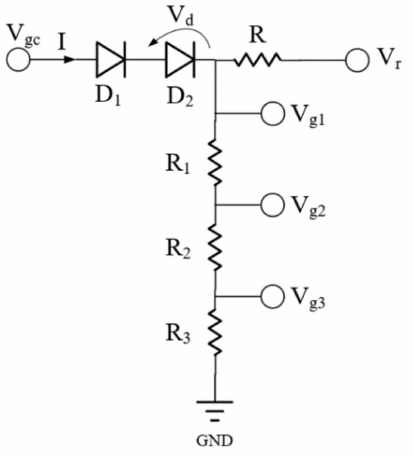
Figure 2. Schematic diagram of the compensation